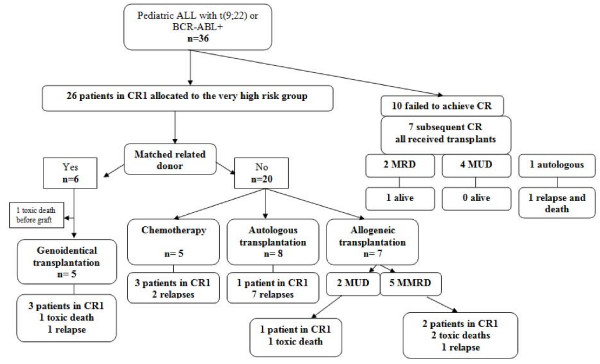
flowchart of the FRALLE 93 trial for philadelphia chromosome-positive ALL. Children with ALL were allocated to very high risk group as soon as a t(9;22) or BCR-ABL rearrangement was detected. Post-induction treatment was then stratified according to availability of an HLA-matched sibling. CR1 = first complete remission; MRD = matched related donor; MUD = matched unrelated donor; MMRD = mismatched related donor.